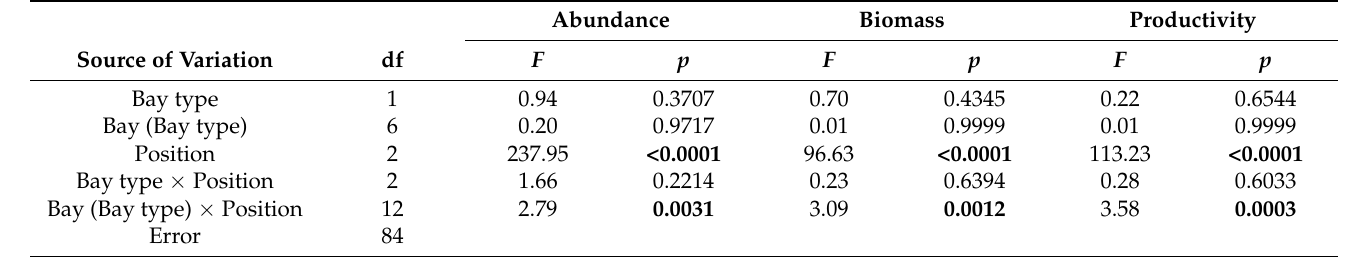
Table 6. Results of ANOVAs with contrasts to evaluated fixed-effects Bay type (with vs. without Styela clava ) and position (inside vs. outside mussel leases) on abundance, biomass, and productivity of all “benthic” macroinvertebrates sampled: sediment + mussel sock macroinvertebrates in mussel leases, and sediment macroinvertebrates outside leases. Random effects Bay (Bay type) and Bay (Bay type) × Position are also shown. All data were log (x + 1) transformed. Statistically significant effects are indicated in bold.